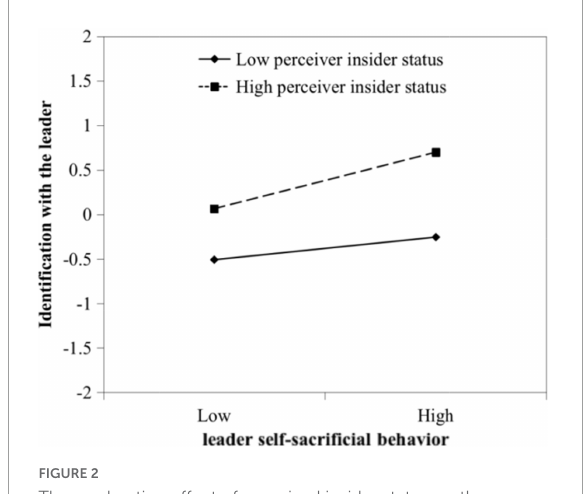
FIGURE2 The moderating effect of perceived insider status on the relationship between leader self-sacrificial behavior and identification with the